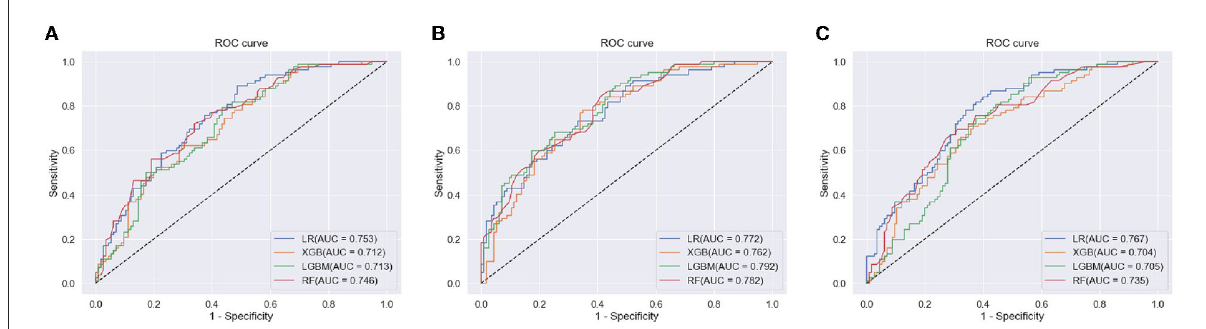
FIGURE5 The ROC curve of each ML model for the prediction of progression to dementia within 2 years. (A) clinical Data, (B) clinical data with CVRS, and (C) clinical data with cortical